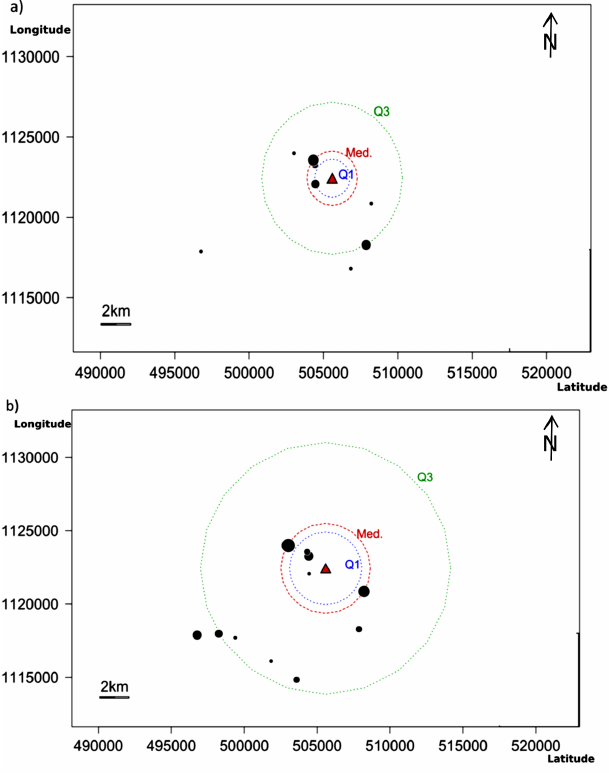
Fig. 5 . Geographical extent of the network: a) in 2010 and b) in 2011. The red triangle represents the study site. The first quartile (in blue) indicates that 25% of the seed acquisitions occurred within this radius. The red median delimits the area 2010 within which 50% of the seed acquisitions took place, and the third quartile (in green) corresponds to the distance within which 75% of seed acquisitions unfolded. The point size represents the number of seed acquisition events at this